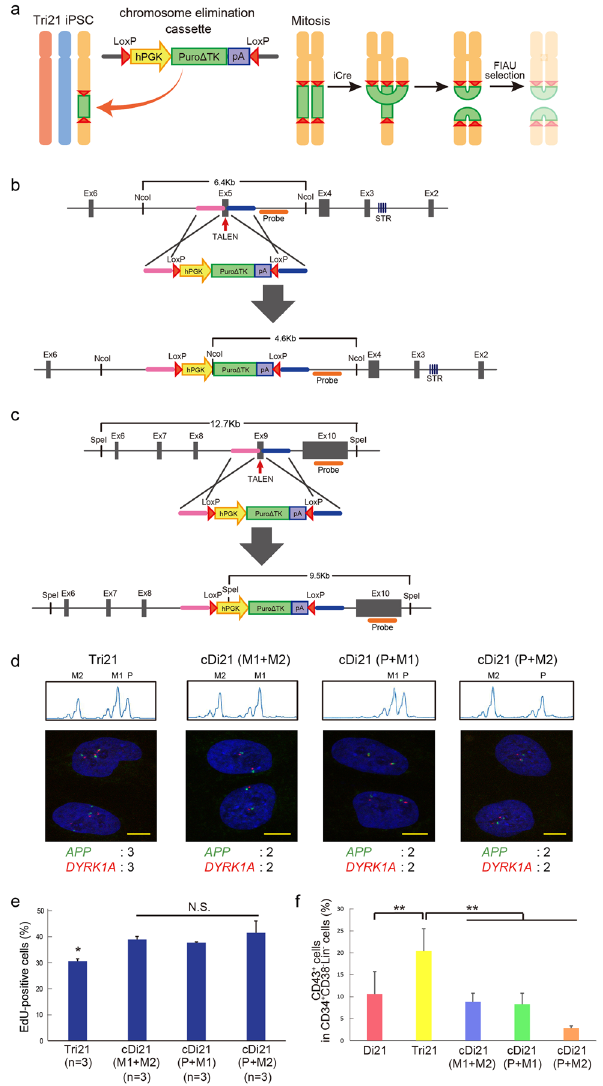
Figure 2. Establishment of corrected Di21 iPSCs. ( a ) Method for establishing corrected Di21 (cDi21) iPSCs using chromosome elimination technology. Chromosome elimination cassette was introduced into one of three copies of chromosome 21 in Tri21 iPSCs by TALENs. Cre–loxP-mediated recombination between sister chromatids in mitosis caused dicentric chromosomes and those without centromeres. Daughter cells without these aberrant chromosomes were obtained using FIAU selection. ( b,c ) Targeting strategy for introducing chromosome elimination cassette into ( b ) RUNX1 and ( c ) ETS2 loci on chromosome 21. Enlarged illustrations indicate each gene locus, including exons (grey boxes), TALEN target sites (red arrows), microsatellite sequences (purple stripe), homology arms (pink and blue bars) and probes for Southern blot analysis (orange bars). Below are illustrations of each donor plasmid including homology arms, human PGK promoters, drug-resistance genes (Puro Δ TK), poly(A) sequences and loxP sequences (red triangles). Puro Δ TK, fusion protein of puromycin and a truncated version of herpes simplex virus type 1 thymidine kinase. In targeting RUNX1 and ETS2 genes, STR and SNP analyses were used, respectively, to identify the parental origin of chromosome 21. ( d ) Top: Short tandem repeat (STR) analysis in each human iPSC (hiPSC) line. STR analysis of the patient with DS and his parents was performed to identify each allele of the RUNX1 gene in Tri21 iPSCs. STR sequences of RUNX1 were compared between Tri21- and each cDi21-iPSCs. Bottom: DNA FISH of chromosome 21-specific probes. APP gene was labelled with DyLight488 (green) and DYRK1A gene was labelled with DyLight594 (red) probe. Nuclei were stained with DAPI. Expected numbers of APP and DYRK1A foci in each iPSC line are shown below. cDi21(M1 + M2) and cDi21(P + M1) were established through RUNX1 targeting, while cDi21(P + M2) was established through ETS2 targeting. Scale bars represent 10 μ m. ( e ) EdU cell proliferation assay in each hiPSC line. Graph shows the proportion of EdU-positive cells. ( f ) Haematopoietic differentiation of each cell line. Graph shows the proportion of CD43-positive cells in CD34 + CD38 − Lin − cells derived from day 8 embryoid bodies (n = 3). Error bars represent SEM. p values were determined by Student’s t-test. * p < 0.05, ** p <